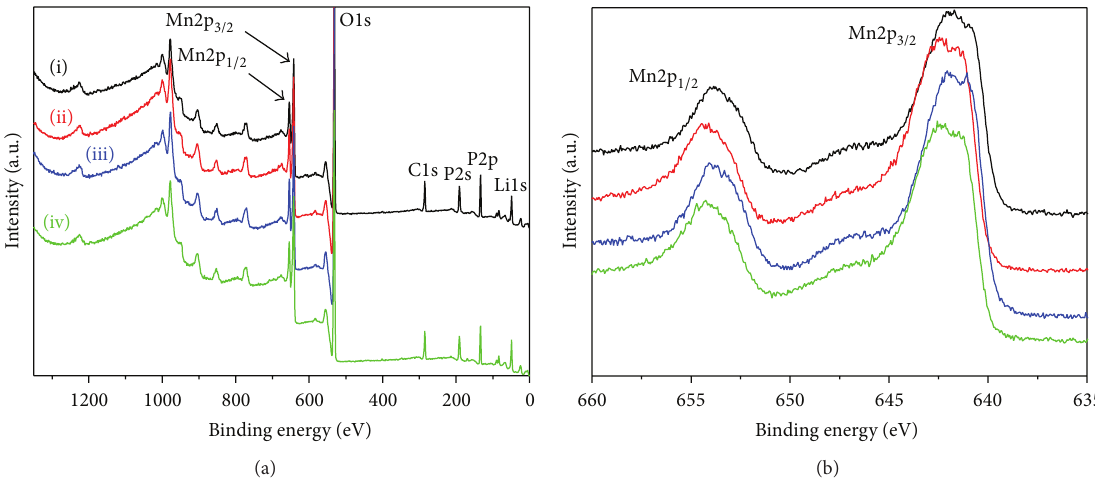
Figure 2: (a) XPS wide scan spectrum and (b) narrow scan Mn2p spectrum for LiMnPO 4 using various precursors: (i) sample A, (ii) sample B, (iii) sample C, and (iv) sample D.